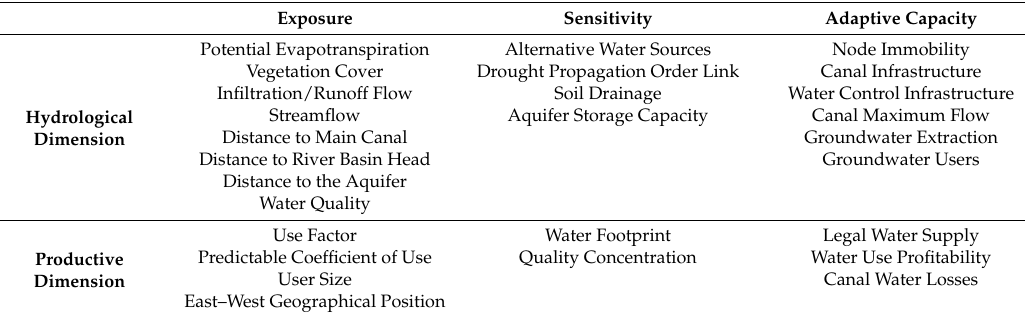
Table 4. Theoretical matrix for contextual vulnerability